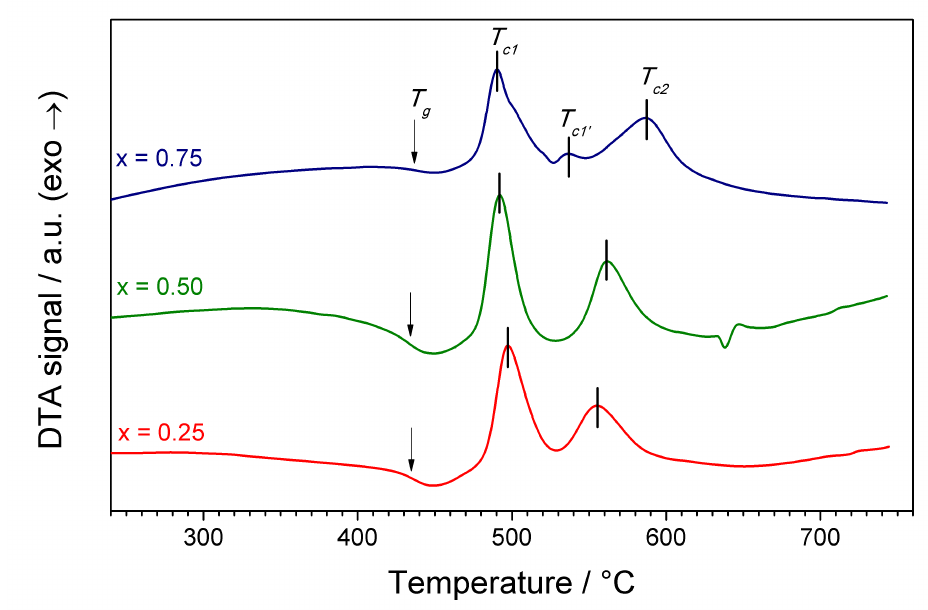
Figure 1. DTA curves for Li(Fe 1 − x Mn x ) 0.88 V 0.08 PO 4 glasses measured in argon flow with a heating rate 10 °C/min. © The Electrochemical Society. Reproduced from Ref. [12] by permission of IOP Publishing. All rights